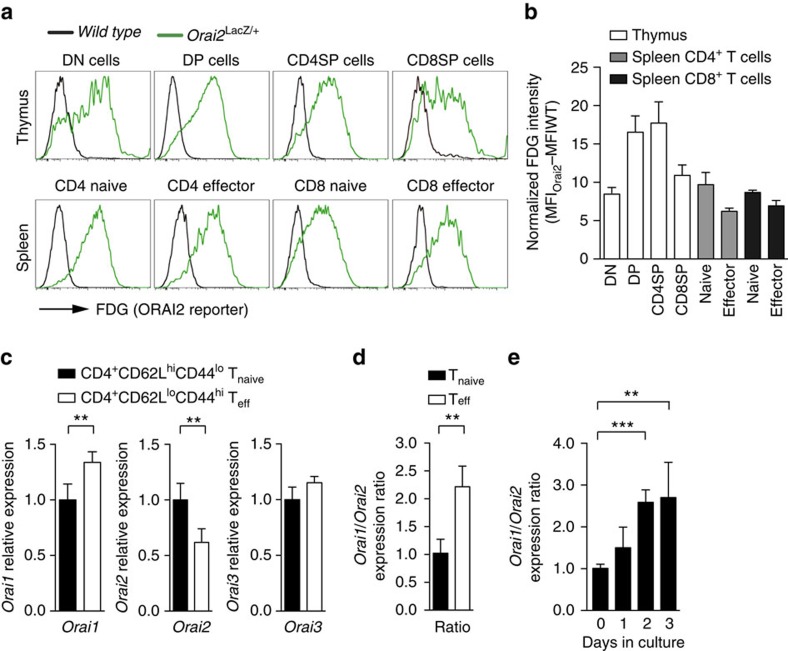
Expression of Orai1 and Orai2 genes in T cells.(a,b) LacZ expression (Orai2 reporter) in thymic and peripheral T cell populations of Orai2LacZ/+ and WT mice. (a) Detection of the green fluorescent LacZ substrate FDG in T cells from WT and Orai2LacZ/+ mice by flow cytometry. (b) Quantification of normalized FDG fluorescence intensity (MFIOrai2−MFIWT) in thymocytes and splenic T cell populations as shown in a; means±s.e.m. of three mice. DN: CD4−CD8− double negative; DP: CD4+CD8+ double positive; CD4SP: CD4+ single positive; CD8SP: CD8+ single positive. (c) Expression of Orai1, Orai2 and Orai3 genes in FACS-sorted CD4+CD62LhiCD44lo naive (Tnaive) and CD4+CD62LloCD44hi effector T cells (Teff) analysed by qRT–PCR; means±s.e.m. of four mice. (d) Ratio of Orai1 to Orai2 gene expression in FACS-sorted Tnaive and Teff cells; means±s.e.m. of four mice. (e) Ratio of Orai1 to Orai2 gene expression following anti-CD3/CD28 stimulation of murine naive CD4+ T cells in vitro; means±s.e.m. of three mice. *P<0.05; **P<0.005; ***P<0.001 in (c–e) using unpaired Student's t-test.